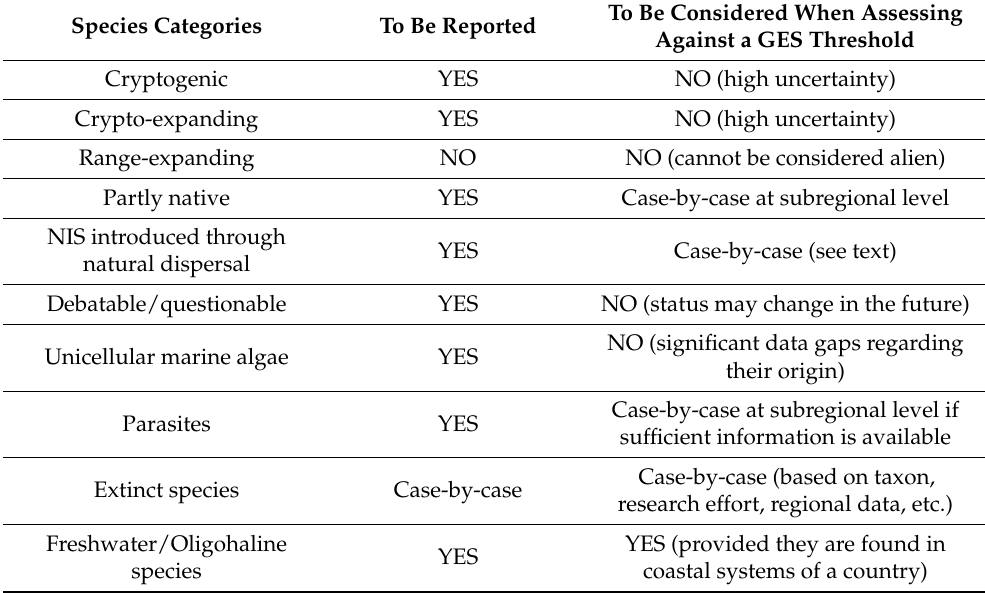
Table 1. Recommendations by non-indigenous species (NIS) experts on elements to be included in the trend indicator (adapted from